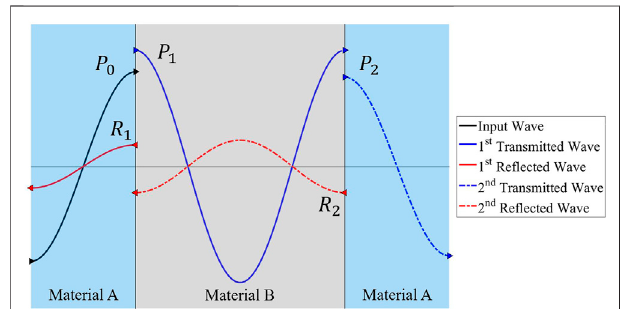
TABLE 1 | Sample material thickness.